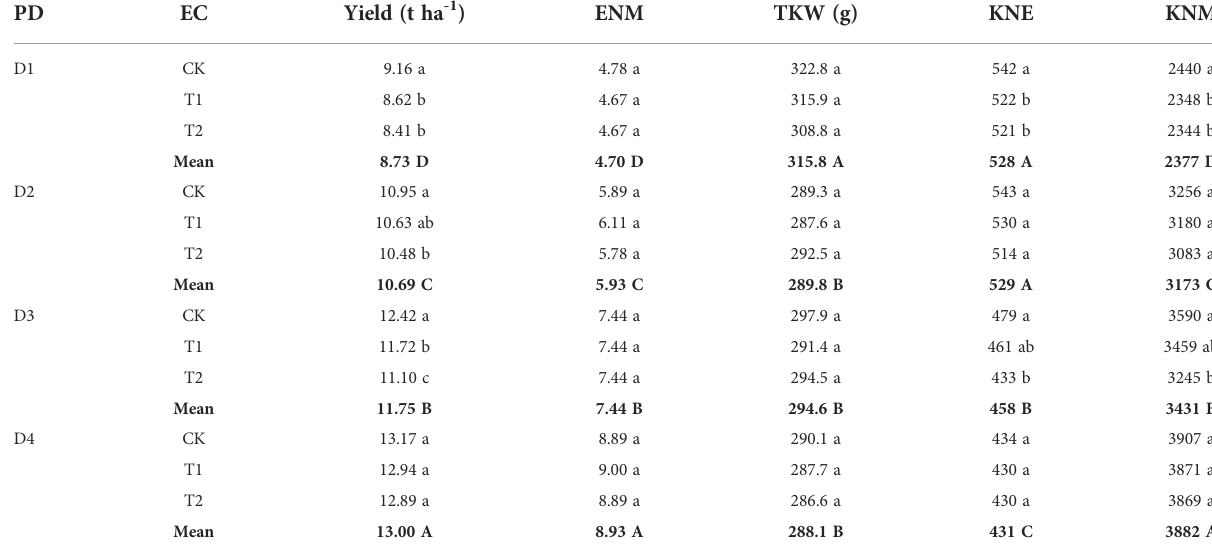
TABLE 1 Effects of plant growth regulator (EC) application and plant density (PD) on maize grain yield and yield components in 2020. PD EC Yield (t ha -1 ) ENM